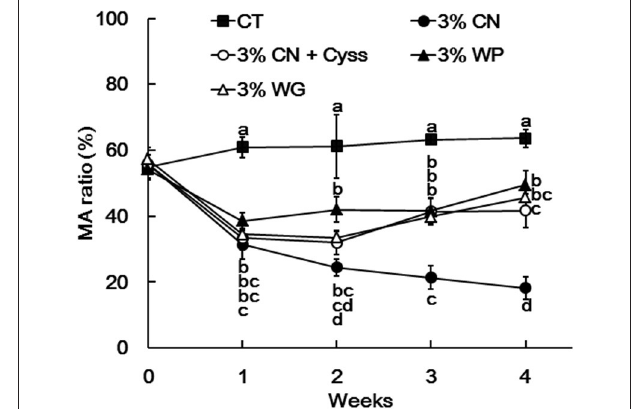
FIGURE 3 | Ratio of mercaptalbumin among total plasma albumin in Experiment 1. Plasma samples, obtained weekly, were subjected to HPLC to determine albumin redox state. Ratios of mercaptalbumin (MA) among total albumin are shown as means ± SD ( n = 6); values with different letters are significantly different at each time point ( P < 0.05). CN, CT, Cyss, WG, and WP denote casein, control, cystine, wheat gluten, and whey protein, respectively.